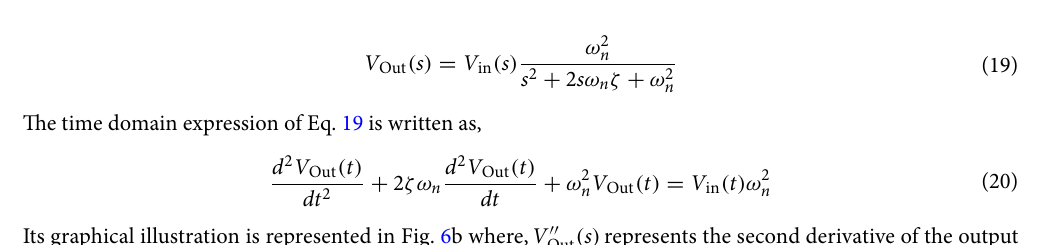
Figure 5. Energy enhancement under feedback. ( a ) Thermodynamic fluctuations from a thermal source get coupled to a fluid system leading to generation of acoustic wave which generates an RF field. The voltage and current is eventually dissipated as heat which is fed to the thermal source. ( b ) The energy can oscillate between acoustic and RF field under interation with a thermal source ( c ) At the start of the measurement process, at time t 0, the noise voltage in the frequency domain, V ( s ) = an interaction between the input voltage and the system’s transfer function. The net voltage fed at the input is expressed as V FB ( s ) which is algebraically added to the input voltage V in ( s ) , which is associated with thermal